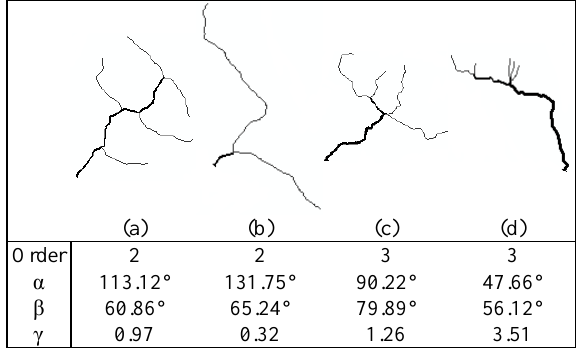
Figure 10. Unclassified